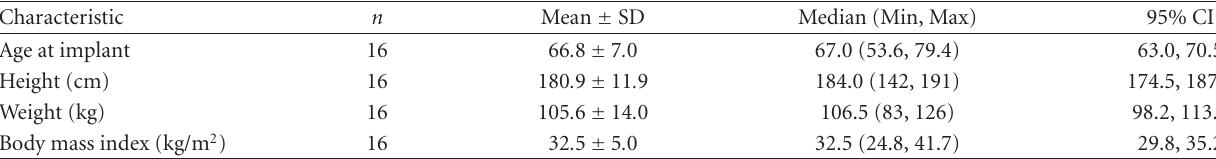
Table 1: Demographic data of study